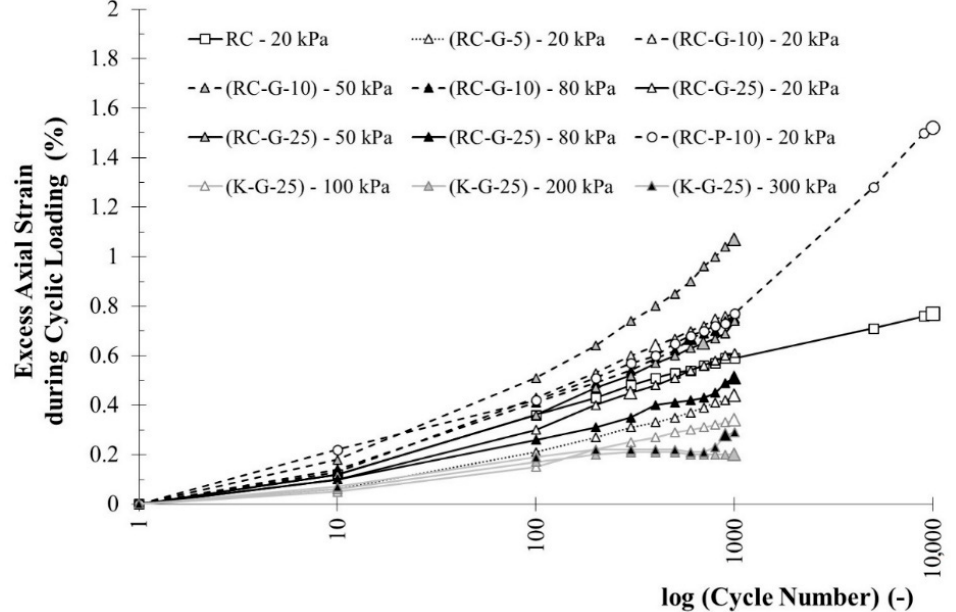
Figure 4. Variation in the axial strain ε 1,cyc with the cycle number from 1–10,000 cycles (the horizontal axis is logarithmic).